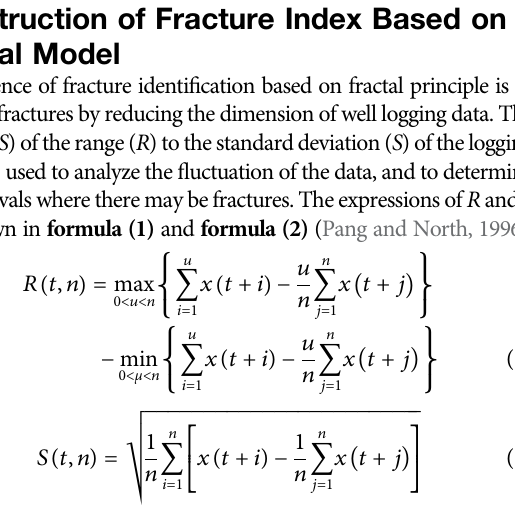
Frontiers in Earth Science |